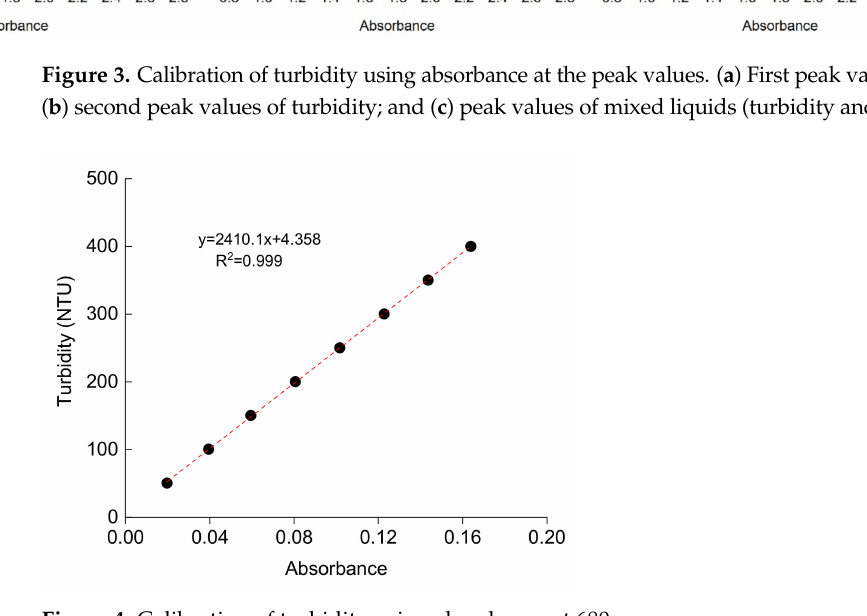
Figure 4. Calibration of turbidity using absorbance at 680 nm. Table 2. Effect of Chlorella on turbidity